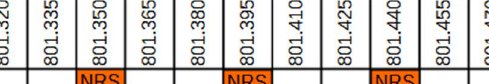
Figure 8. Example of time acquisition of a subcarrier transmitting the NRS (801.440 MHz).